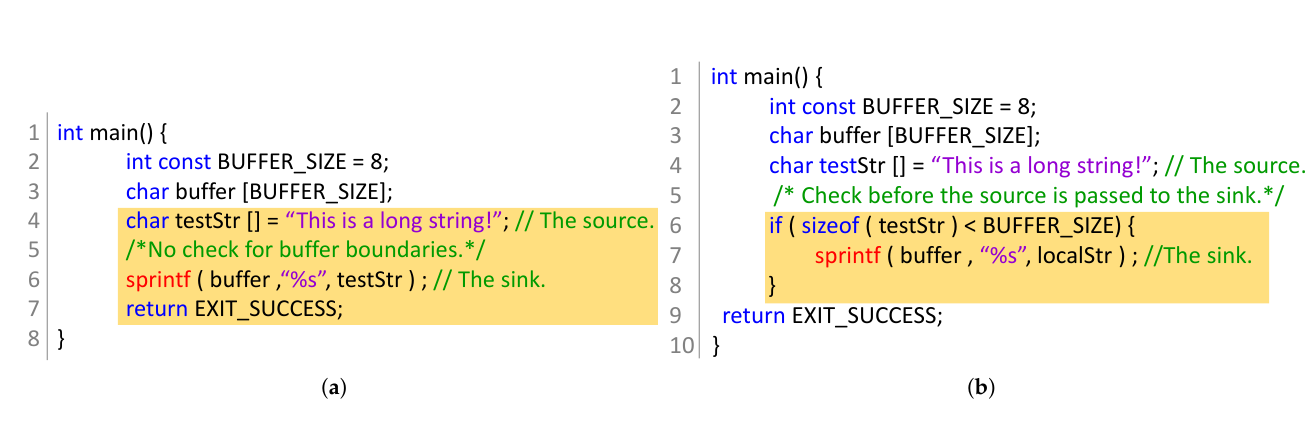
Figure 2. The different contexts of the target token sprintf (red). ( a ) The potentially vulnerable context (yellow) of target token (red): sprintf . ( b ) The patched context (yellow) of target token (red): sprintf